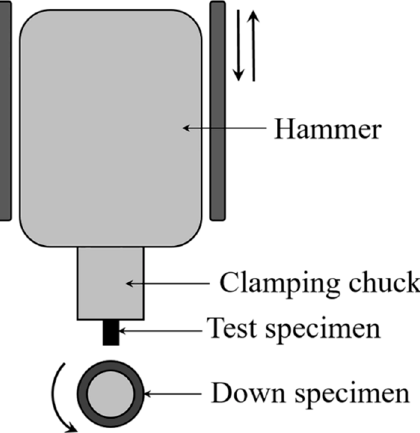
Figure 1. Schematic illustration of the MLD-10 impact wear tester.